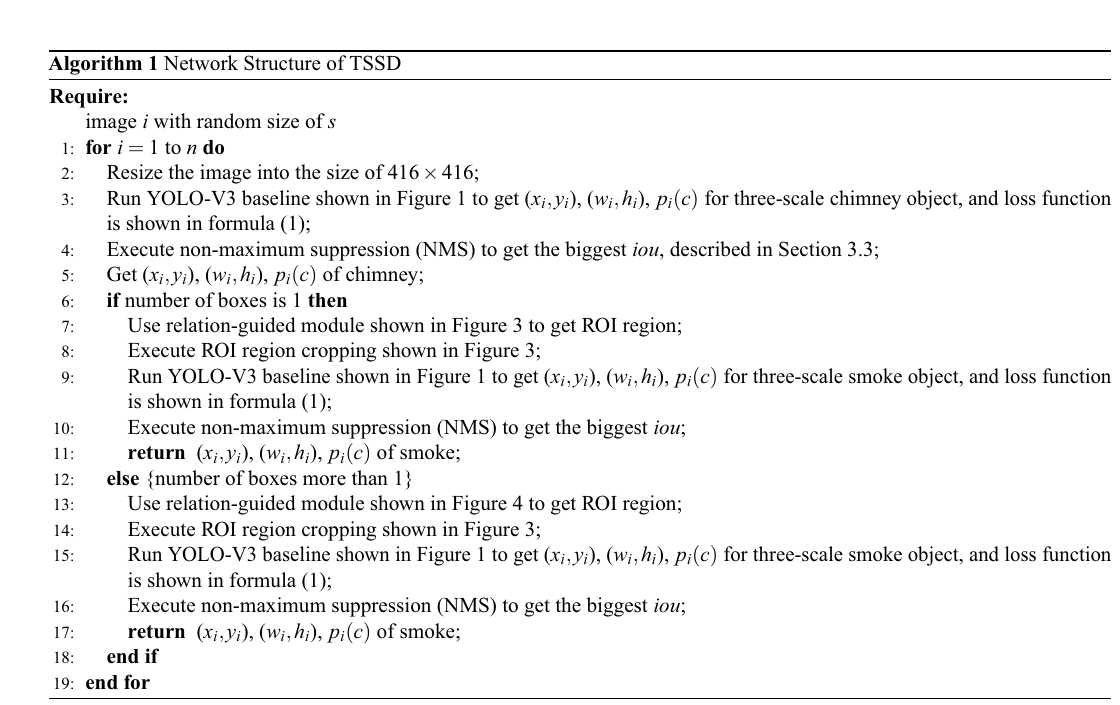
Figure 2. Cascaded-Blocks of Conv2d 1 × 1 and Conv2d 3 × 3 . (a) Denotes ‘Residual Block‘ to extract relative low-level smoke features, where n is 1,2, 8,4, from left to right. (b) Denotes ‘Detection Block‘ to extract relative high-level smoke features, where n is 3. Compared with (b) , the residual connection of (a) can help to capture more feature